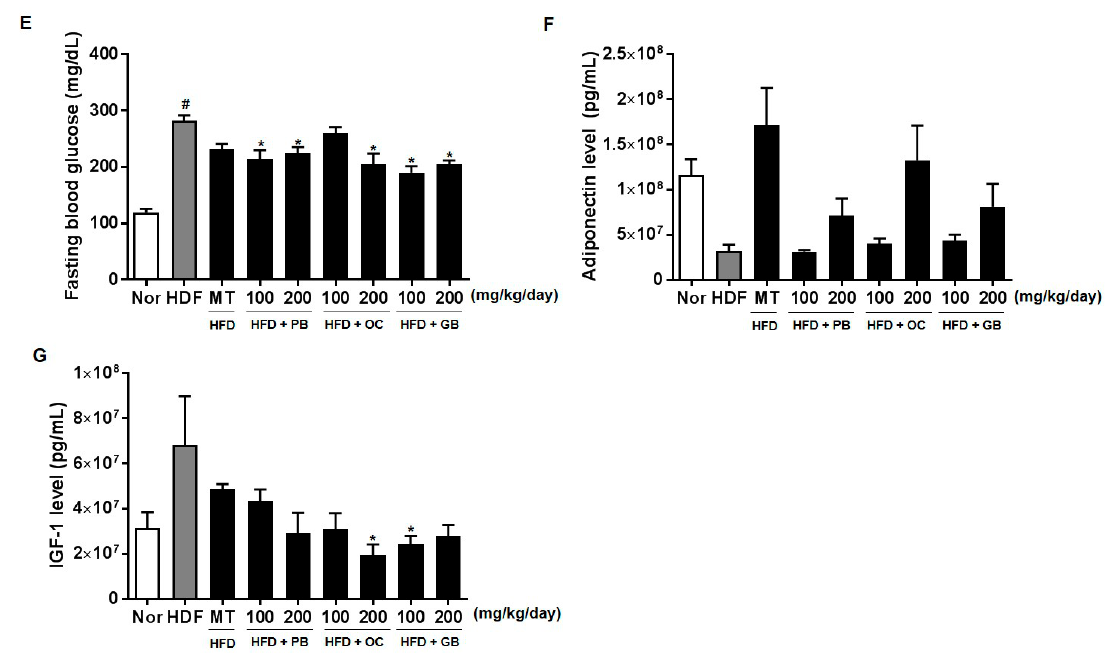
Figure 5. Effects of PB, OC, and GB extracts on blood biochemistry parameters in HFD-fed mice. ( A ) Serum low-density lipoprotein (LDL) cholesterol, ( B ) serum high-density lipoprotein (HDL) cholesterol, ( C ) serum FFAs, ( D ) serum creatine, ( E ) fasting blood glucose, ( F ) serum adiponectin, and ( G ) serum IGF-1 levels. The data are presented as the mean ± SEM ( n = 9); # p < 0.05 compared with the control group; * p < 0.05 compared with the HFD group.